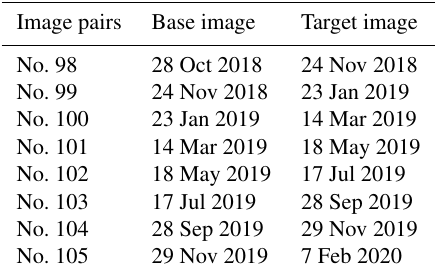
Table 2. Eight periods (image pair no. 98–no. 105) were used to derive the Mindu slope